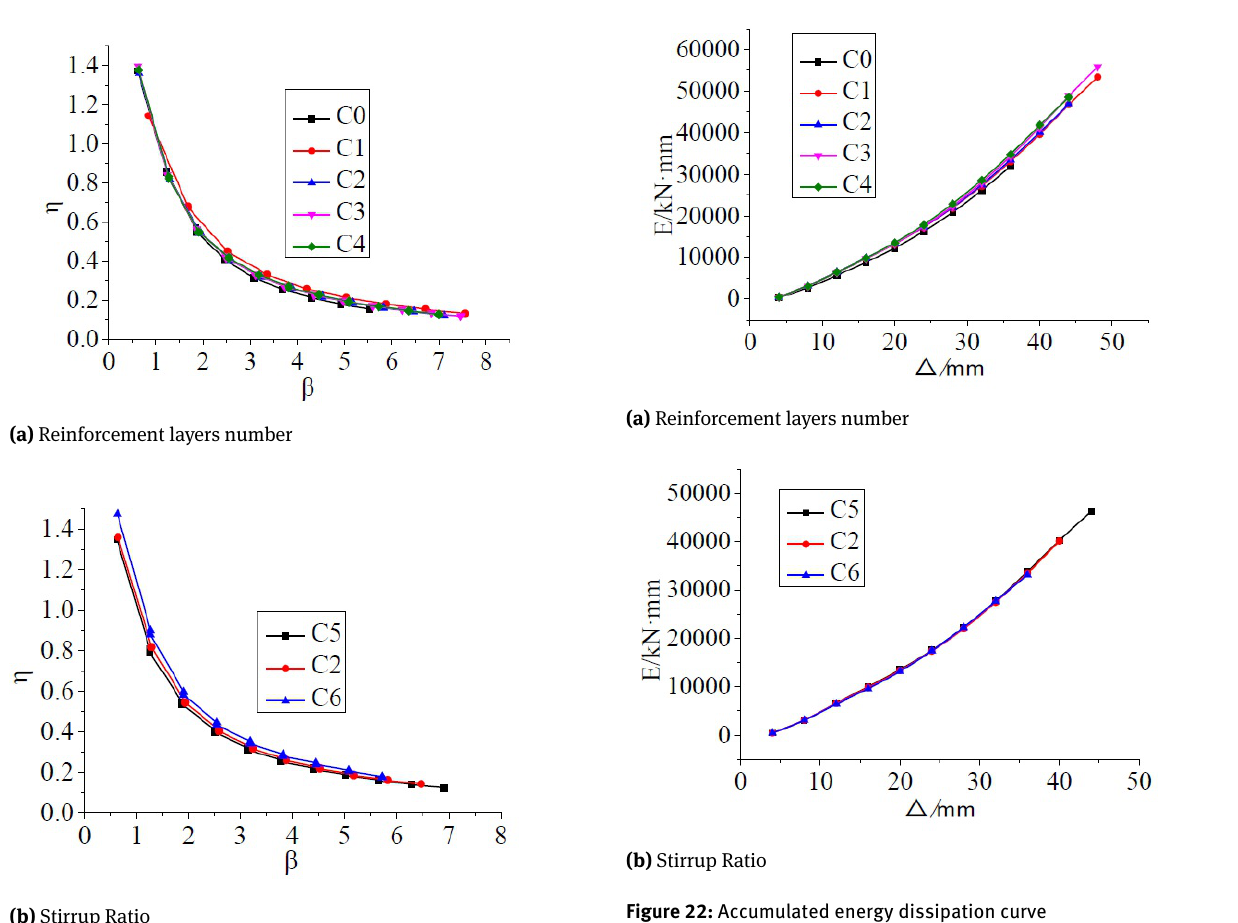
Figure 21: The stiffness degradation curve